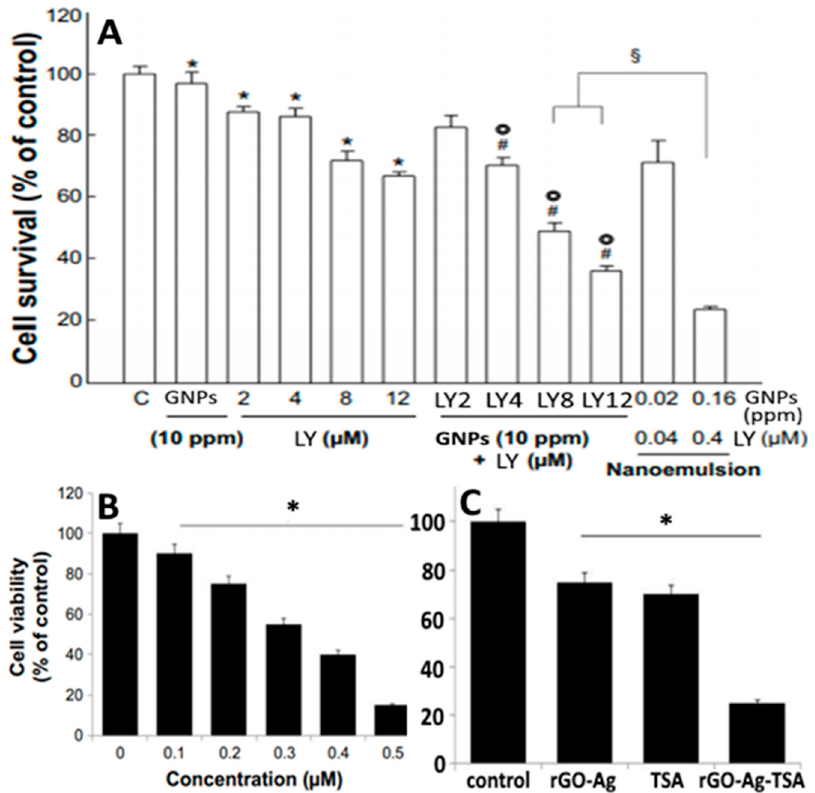
Figure 15. In vitro anti-colon cancer activity and anti-ovarian cancer activity exerted, respectively, by lycopene-gold nanoparticles based nanoemulsion towards HT-29 cells ( A ) and lycopene reduced graphene oxide silver nanoparticles towards SKOV3 cells ( B ). In ( A ), inhibitory effects of different doses of commercial gold nanoparticles and lycopene alone or in combination as well as lycopene-gold nanoparticle nanoemulsion on HT-29 cells after incubation for 24 h. In ( B ), cell viability of SKOV3 cells upon treatment with different doses of lycopene reduced graphene oxide silver nanoparticles (0–0.5 µM) ( B ), while ( C ) showing comparison of cell viability upon treatment with rGO-Ag alone (0.2 µM), trichostatin A alone (0.2 µM) and both rGO-Ag and trichostatin A in combination (0.2 µM each). The results were expressed as mean ± standard deviation of ≥ 3 independent replicates and error bars represent the standard deviation from mean values. *, ⌾ , #, or § symbols above each bar denote significantly different values. LY = lycopene, GNPs = gold nanoparticles, rGO-Ag = reduced graphene oxide-silver nanoparticle and TSA = trichostatin A. Adapted with permission from Huang, et al. [64] and Zhang, et al. [116].